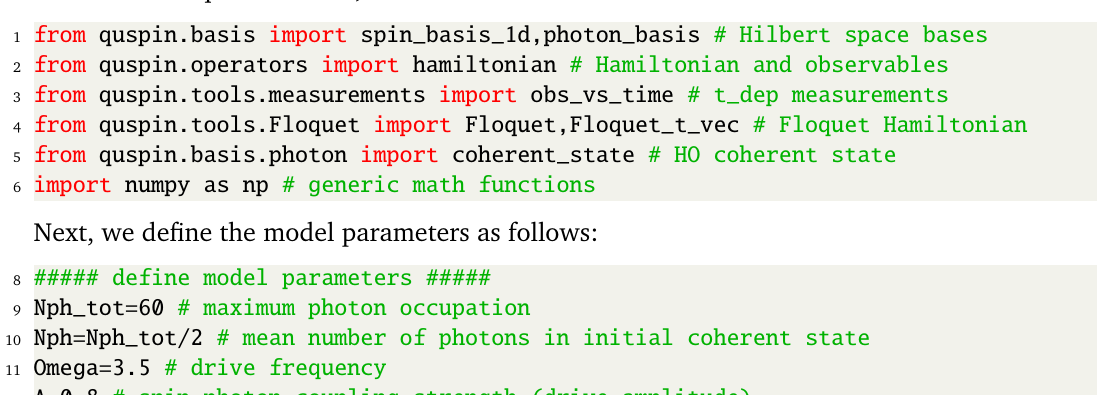
= 60 states, ph,tot = ph